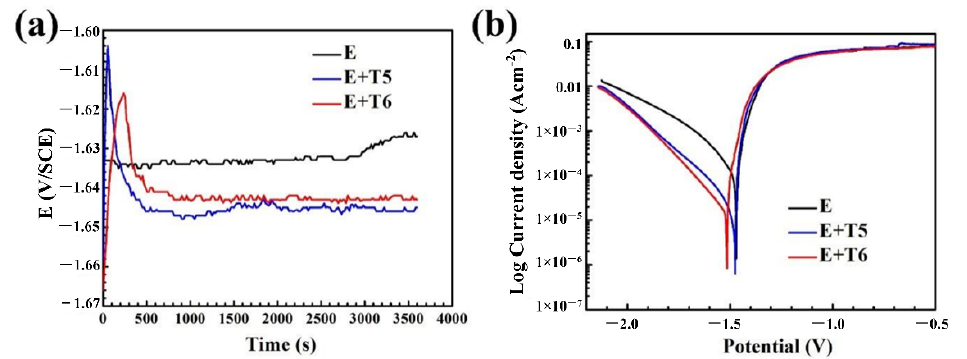
Figure 7. The electrochemical polarization behaviors of as-extruded, T5, T6 specimens in 3.5% NaCl solution: ( a ) Open-circuit potential curve; ( b ) potentiodynamic polarization curves.